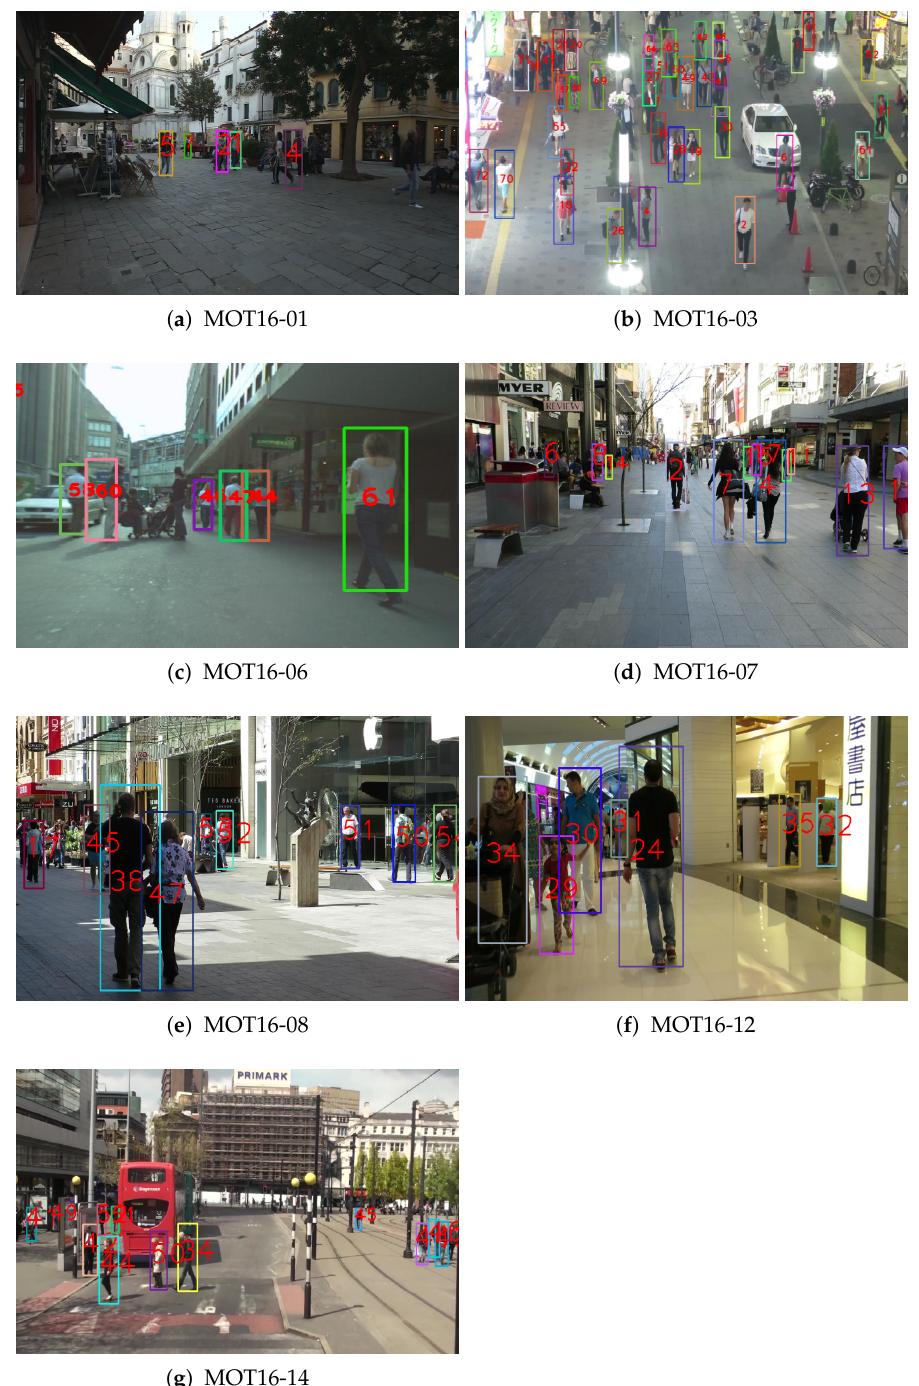
Figure 9. ( a – g ) Tracking results using the proposed MOT method with global appearance and motion models on the 2016 MOT benchmark test